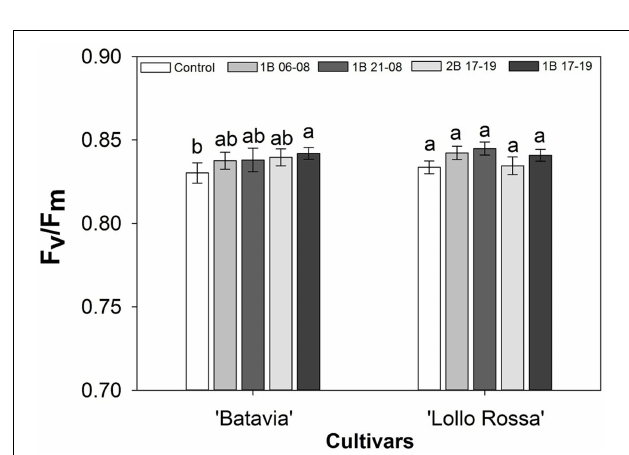
FIGURE 4 | Maximum photochemical efficiency of PSII (F v /F m ) of Lactuca sativa “Batavia” and “Lollo Rossa” grown under the five different LED treatments with the same abbreviations as in Figure 2. Data are mean values ( n = 16, four replications, four different leaves from different plants per treatment and cultivar) ± SE. Assignment of the same letters indicates values that are not significantly different at P -values < 0.05 within